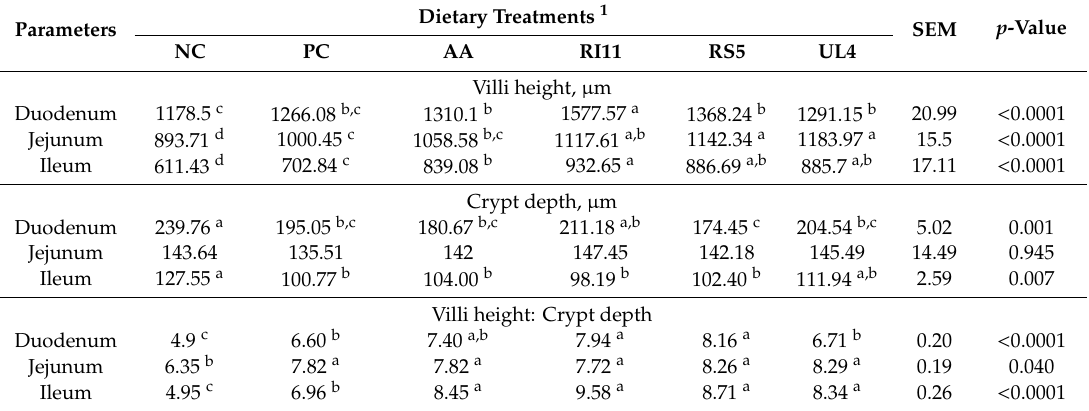
Table 6. Intestinal histology of broiler chickens fed di ff erent postbiotics under heat stress.